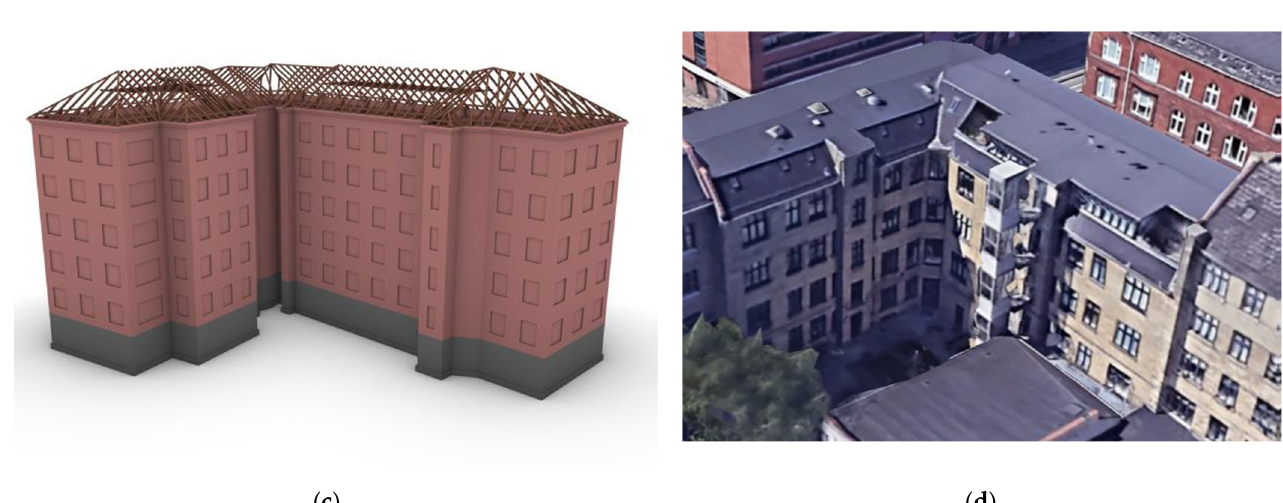
Figure 2. Based on typological rules and drawings, typical floor for typology ( a ), and typical roof build-up several alternatives for the typology ( b ), it is possible to generate a full 3D representation of a building ( c ). The visual inspection shows that the BIM generated roof ( d ) is of the wrong type of the two typical roof construction alternatives, meaning changes of specific fixed or free parame- ters need